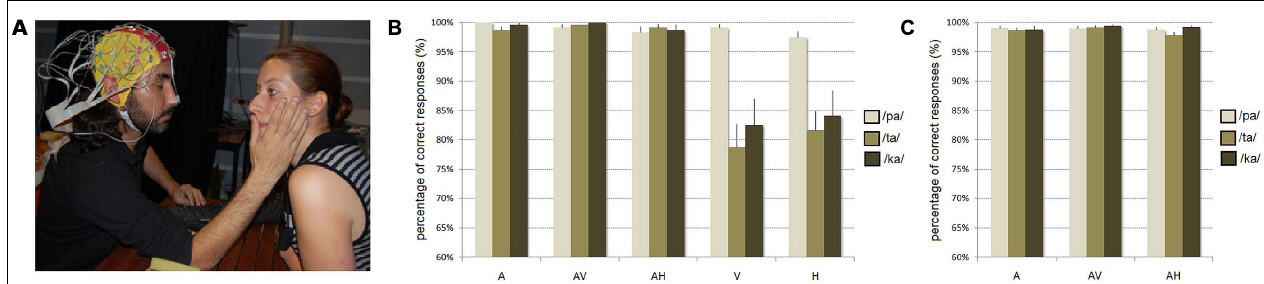
FIGURE 1 | (A) Experimental design used in the audio-haptic (AH) modality. In the haptic (H) and AH modalities, participants were asked to keep their eyes closed with their right hand placed on the experimenter’s face and to categorize with their left hand each perceived syllable. In the auditory modality (A), participants were instructed to keep their eyes closed while, in the visual (V) and audio-visual modality (AV), they were